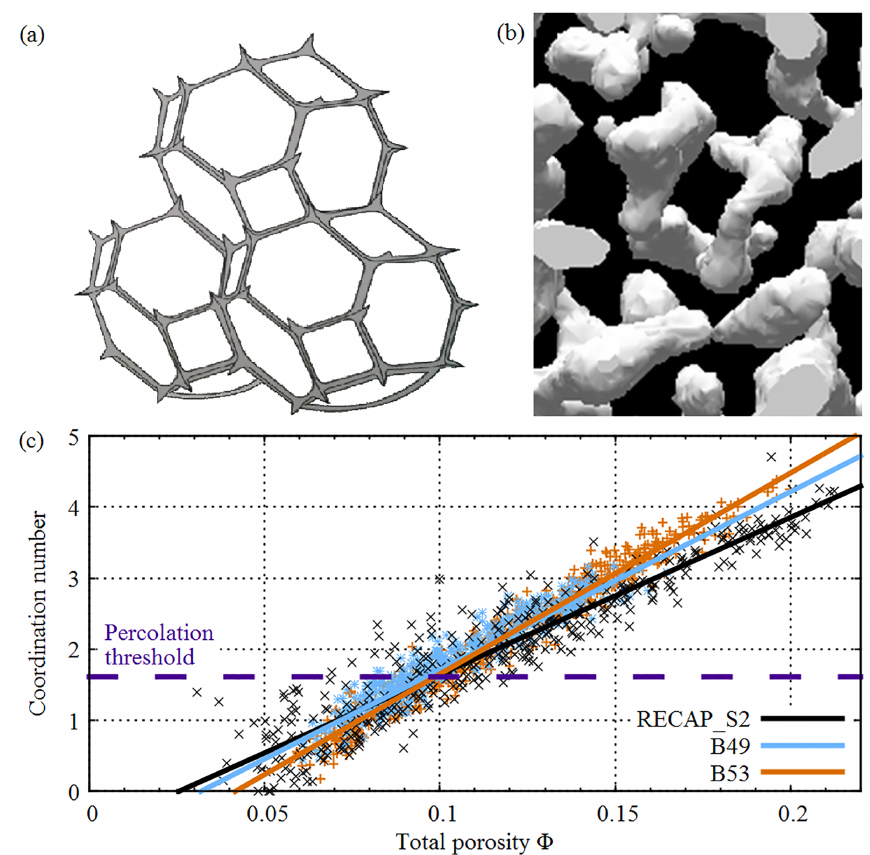
Figure 1. (a) A structure consisting of three packed tetrakaidecahedra. The white bodies represent ice crystals, the gray edges the pore network. (b) Example of a 3-D scan; the pore network is shown in white. (c) Coordination number versus total porosity for our measurements. The threshold for gas enclosure within a single layer as predicted by percolation theory has been marked. Table 1. Details on the analyzed cores. Mean annual temperature is denoted by T and an estimate of yearly accumulation by ˙ a . Drill site Year Elevation T ˙ a Depth interval RECAP_S2 (Renland, Greenland)